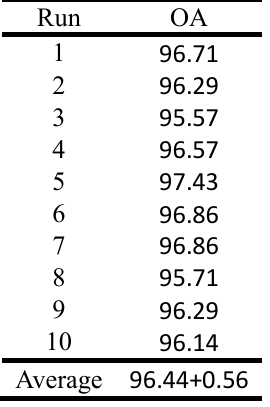
Figure 9. The trend of the sensitivities of class Table 2. Statistical analysis on the overall accuracies